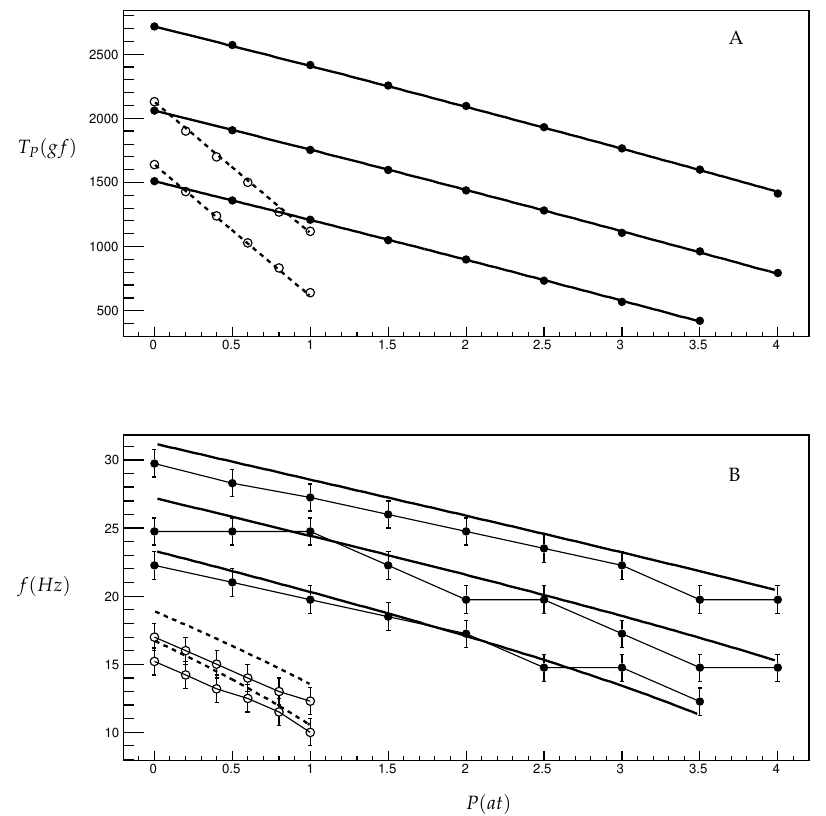
Figure 3. ( A ) Effective tensions T P versus P for different initial tensions T P ( 0 ) . ( B ) Lowest frequency for the corresponding P and T P . Filled circles, 9.8-mm straw; open circles, 18-mm straw. Curves: Equation (3) for the plot A and (A11) for B; solid lines, 9.8-mm straw; dashed lines, 18-mm